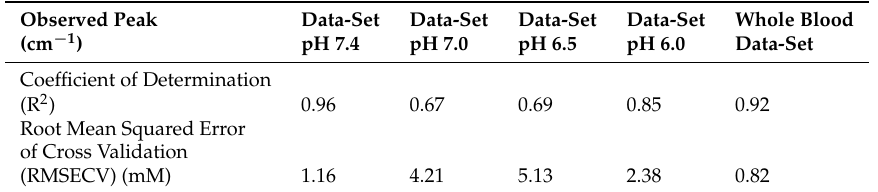
Table 2. The Coefficient of Determination (R 2 ) and Root Mean Squared Error of Cross Validation (RMSECV) (mM) for each data-set, independently.